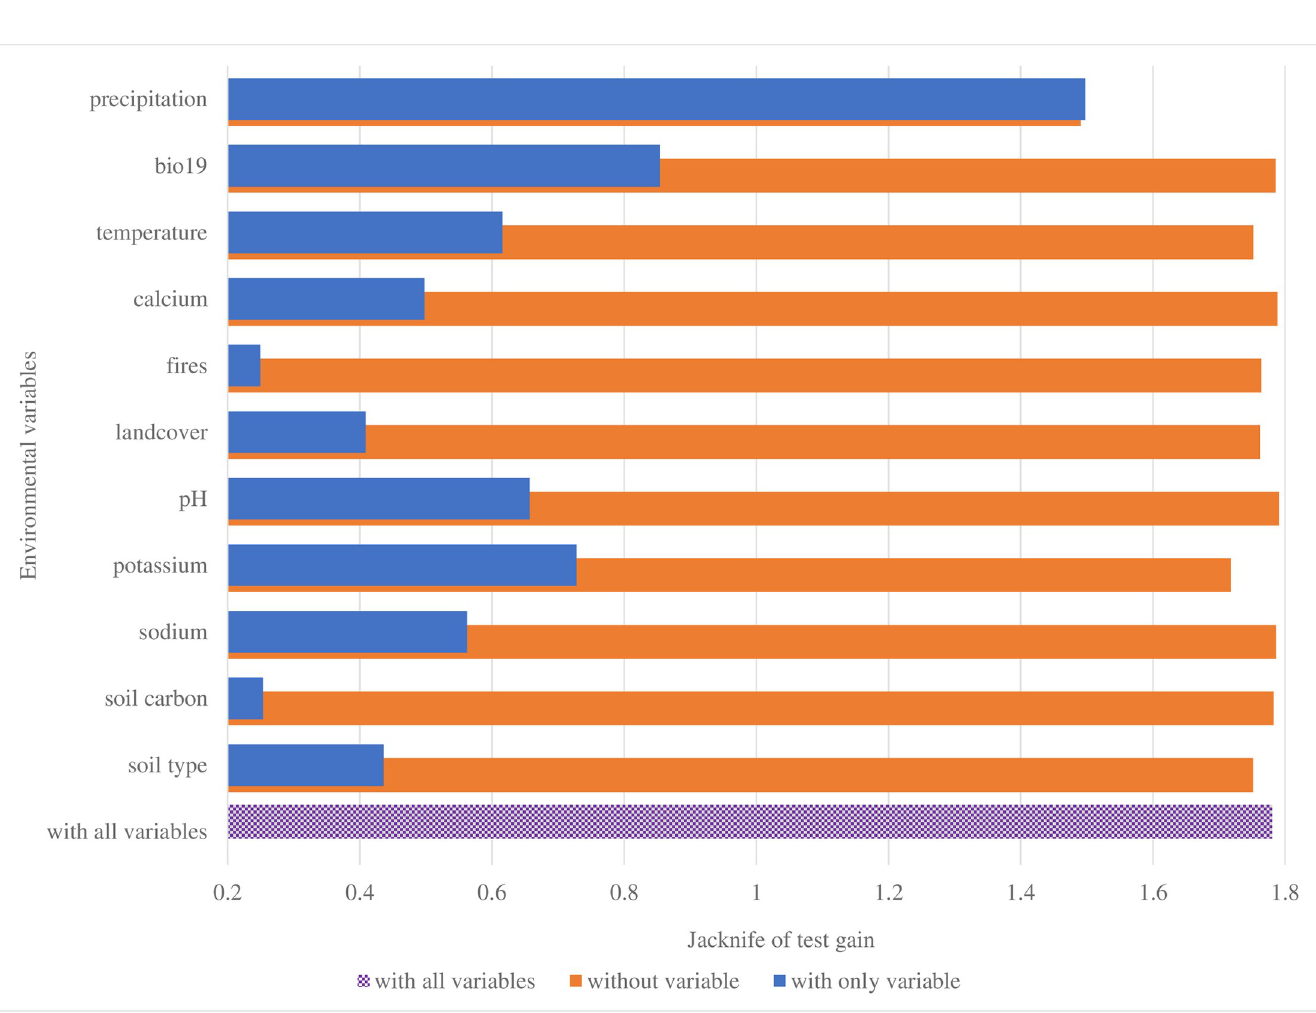
Fig 3. Jacknife test for assessing variable importance using test gain for validating the B . anthracis species survival model. Variable of greatest importance for validating the B. anthracis survival model was bio12_cl. When used in isolation, it contributed the highest gain (1.5) when omitted, decreased the gain the